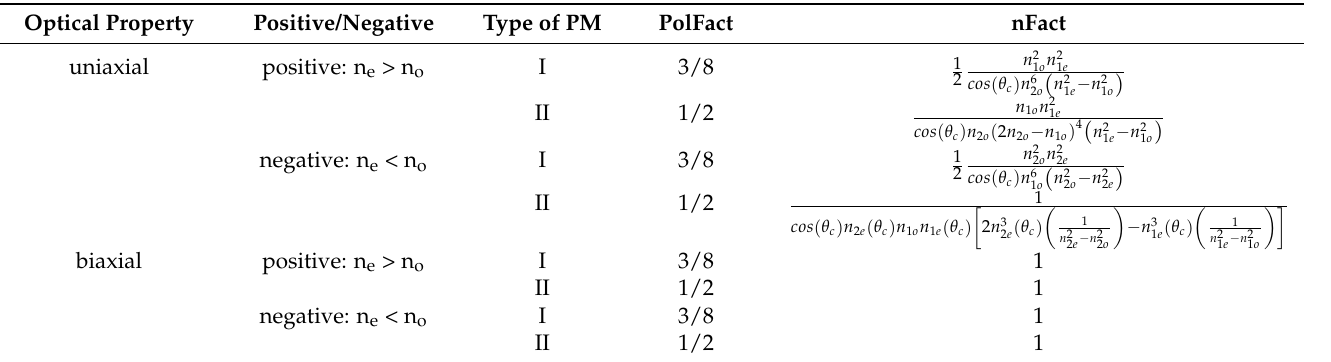
Table 3. PolFact and nFact for each type of